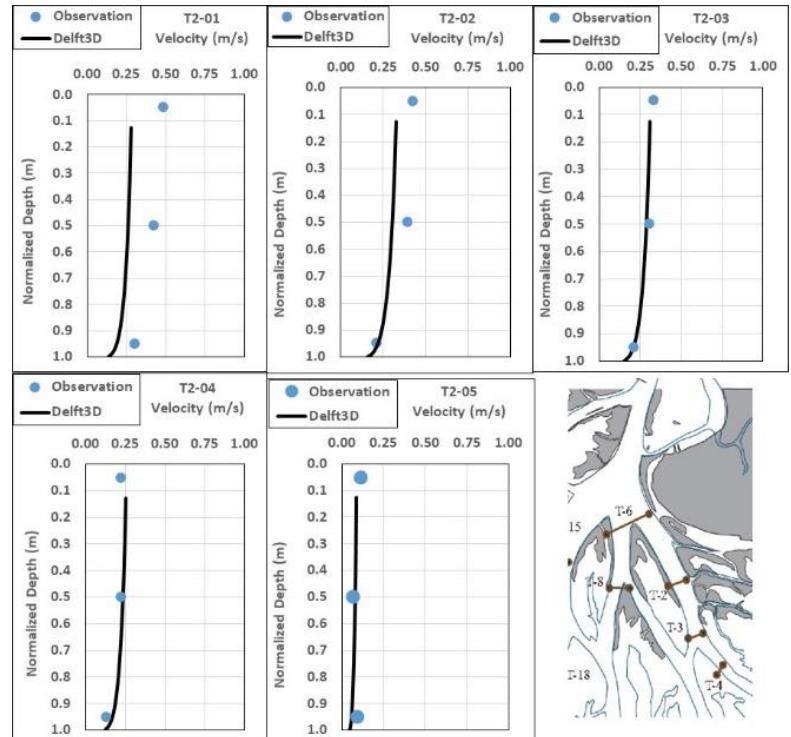
Figure 4. Calibration results showing comparison of modeled and observed streamwise velocities at Gadwall Pass.